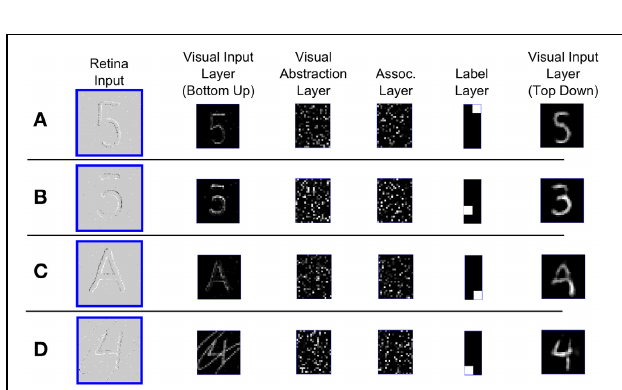
FIGURE 6 | Generation mode of the event-driven DBN. (A) Screen capture of the network while generating samples of input activations corresponding to class “4.” The neuron corresponding to label “4” was stimulated in the Label Layer (left), and activity propagated through the whole network. The snapshot shows a single example of activity in the Visual Input Layer (right) that is sampled from the generative model encoded in the weights of the DBN. Through short-term depressing